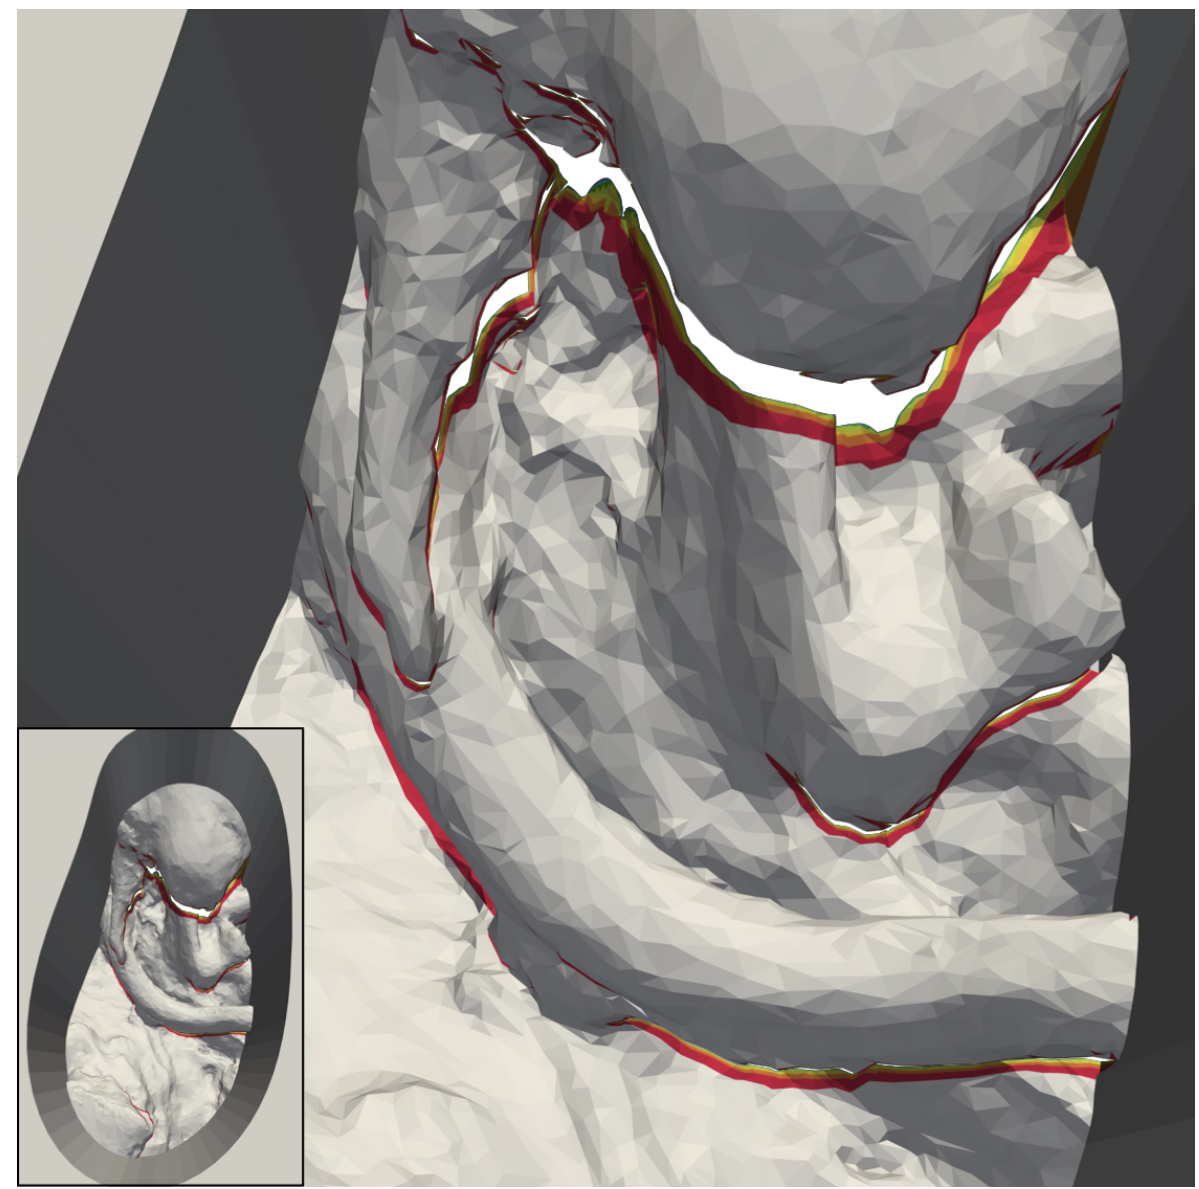
Figure 12. Reconstructable subset of the 50mm deep version of our “elliptical channel” model, using cameras with increased FOV size. The regions shown in grey are reconstructable with only two cameras. The area added by four cameras is red. In addition, shown are additional areas reconstructable with six (orange), eight (yellow), 16 (lime), and 32 (green)